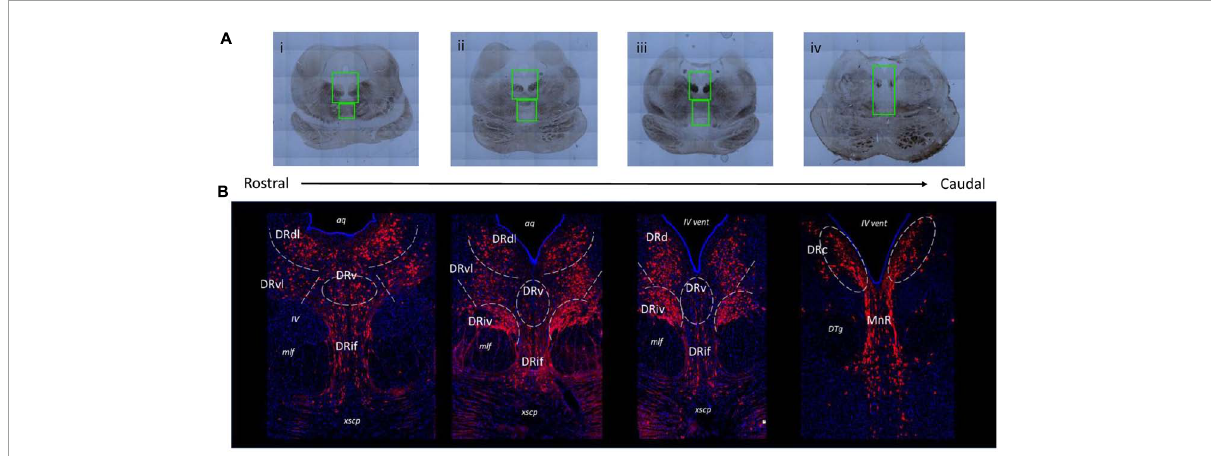
FIGURE1 Representative images of various subnuclei distinctions across the rostral-caudal axis of the greater raphe nuclei. Distinctions were made based on gross anatomical makers such as the size and shape of the periaqueductal gray (PAG) and cerebral aqueduct (aq)/fourth ventricle (iv vent), the presence and location of medial longitudinal fasciculus (mlf), and the presence of fibrous pontine tissue. (A) Example overview images indicating slide scanner imaging areas. Green boxes indicate locations of 20 × magnification images that were used in analysis. (B) Representative images of juvenile Japanese macaque midbrain sections indicating the subnuclei divisions used in subsequent analysis. Gray dashed lines indicate nuclei boundaries the experimenter identified and where rectangular bounding box was placed to produce separate images for each subnucleus. The lateral nuclei (DRdl and DRvl) and the DRiv were separated into left and right components, but only left components are labeled for visualization purposes. Blue: 4 (cid:48) ,6-diamidino-2-phenylindole (DAPI), red: tryptophan hydroxylase 2 (TPH2). DRd, dorsal nucleus of the dorsal raphe; DRdl, dorsolateral nucleus of the dorsal raphe; DRv, ventral nucleus of the dorsal raphe; DRvl, ventrolateral nucleus of the dorsal raphe; DRiv, fourth nerve nucleus of the dorsal raphe; DRif, interfascicular nucleus of the dorsal raphe subnucleus; MnR, median raphe nucleus; xscp, cerebellar decussation; DTg, dorsal tegmental